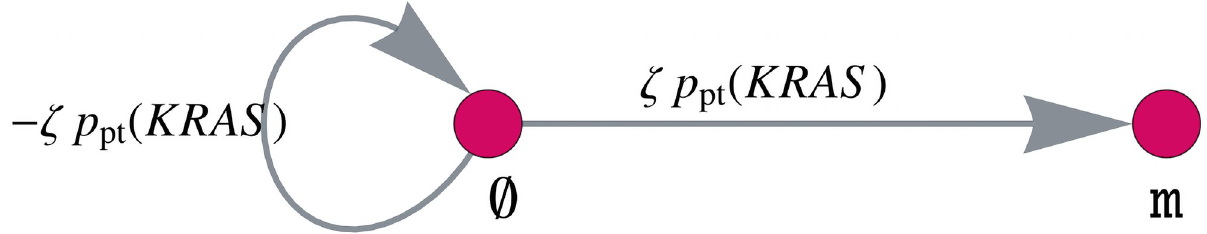
Fig 8. Model component for increasing the mutation rate of KRAS after MMR deficiency. Gene mutation graph of KRAS for the matrix F with the KRAS mutation rate increased by a factor z